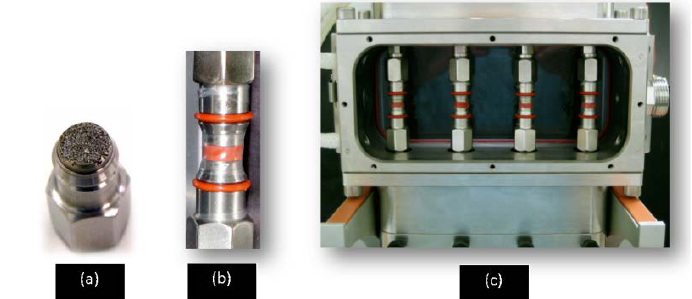
Figure 3. ( a ) A sample platen (b ) An assembled set of sample platens with membrane encased mock scaffold ( c ) The hydrostatic chamber with four mounted mock